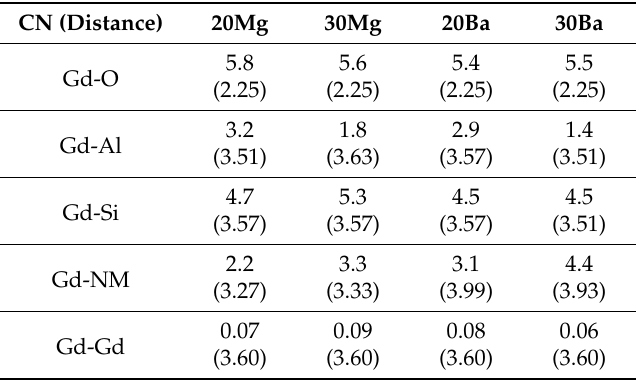
Table 5. Coordination numbers CN (and interatomic distances [Å]) of Gd 3+ ions obtained for different chemical compositions.